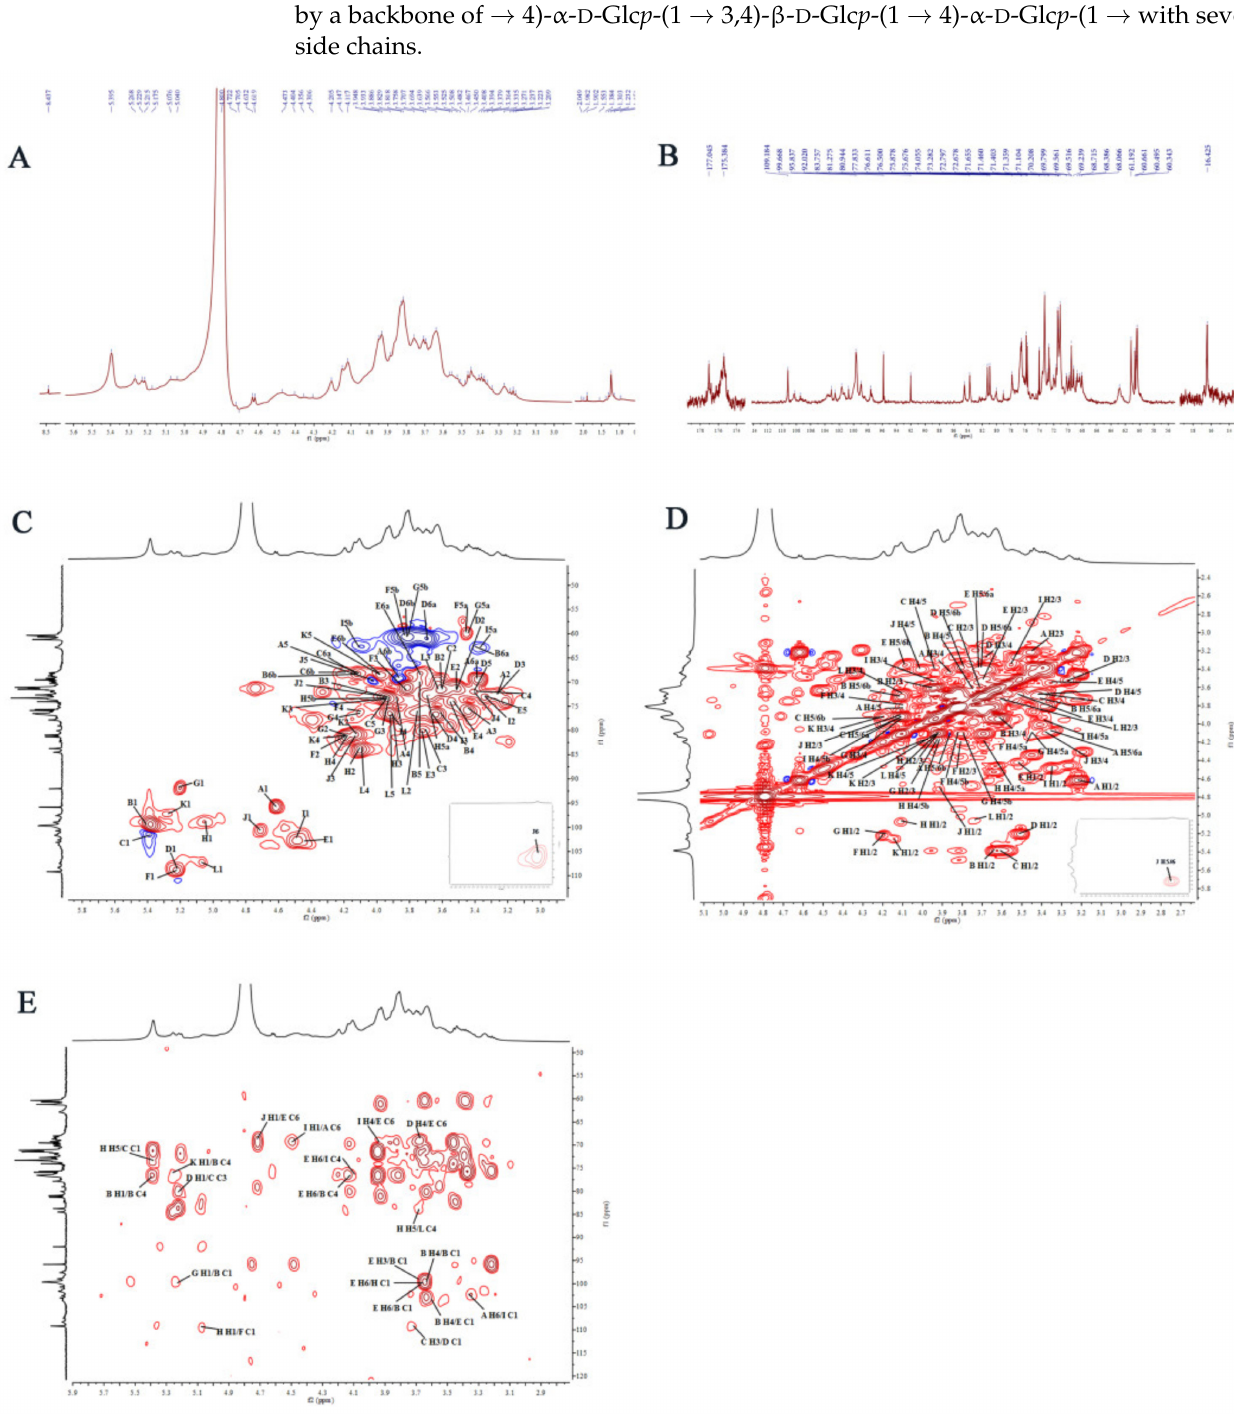
Figure 6. The NMR spectra of AVPG-2 in D 2 O: ( A ) 1 H spectrum; ( B ) 13 C NMR spectrum; ( C ) HSQC spectrum; ( D ) 1 H- 1 H COSY spectrum; and ( E ) HMBC